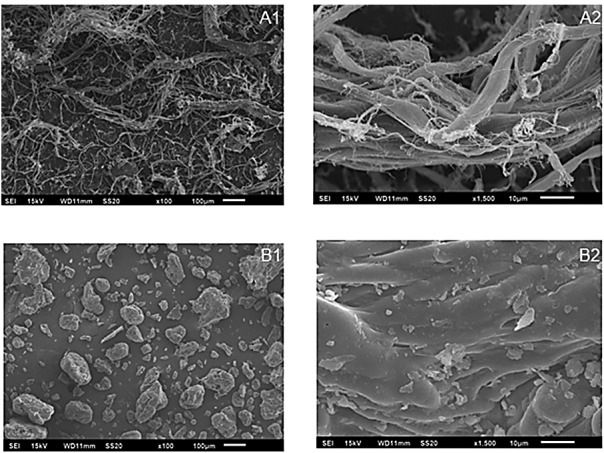
Micrographic images of collagen fibre (A1 and A2) and powder (B1 and B2). Magnification: 1=100× and 2=1500×